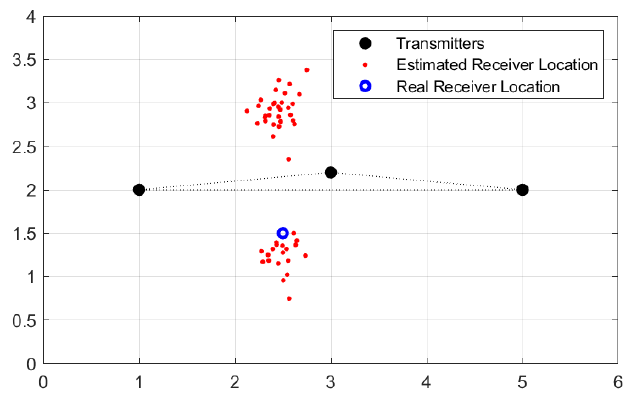
Figure 5. A demonstration of the flip-ambiguity effect when the Txs are placed in a straight or even in a semi-straight